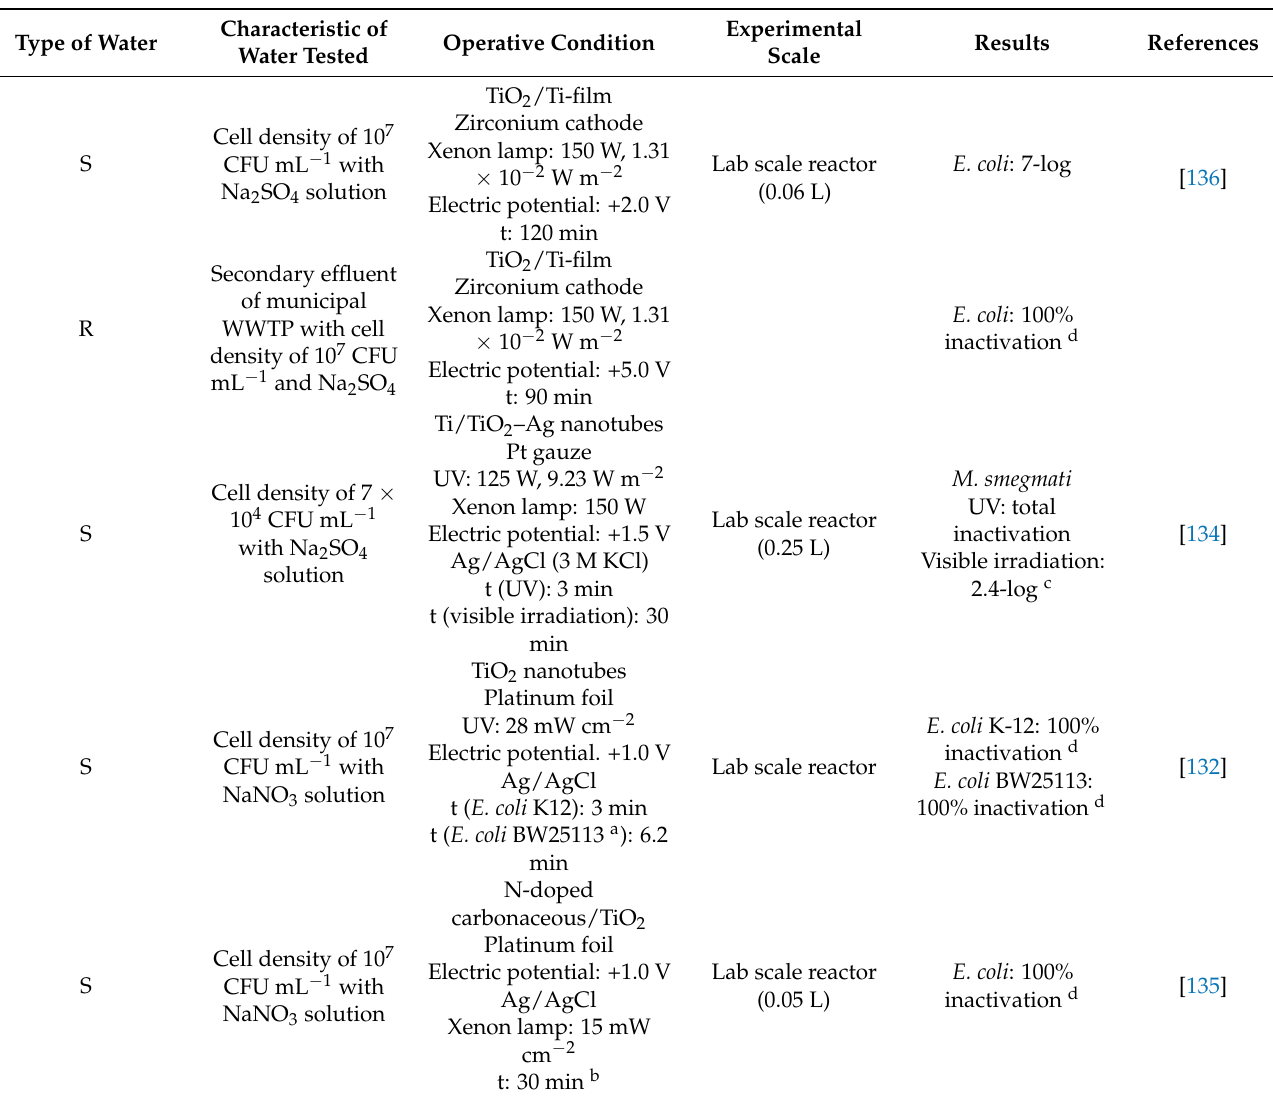
Table 5. Several result of PEC disinfection tests. S: synthetic water, R: real water, UV: ultraviolet radiation, t: contact time. Type of